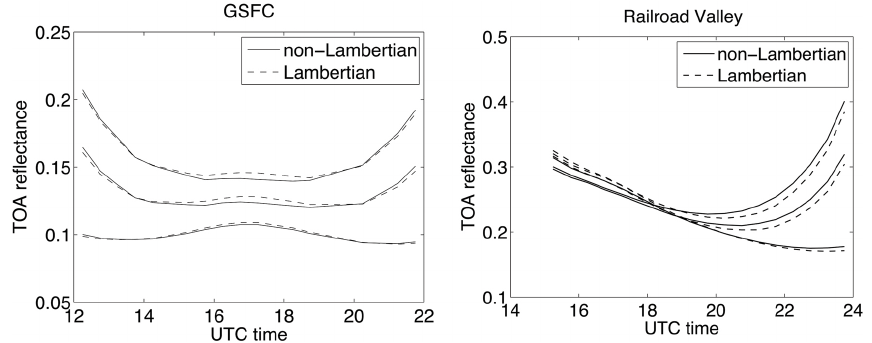
Fig. 8. Comparison of TOA reflectance between Lambertian and non-Lambertian surface at site GSFC and Railroad Valley. The three pairs of lines from bottom to top are calculated using AOD values of 0, 0.5, and 1.0,